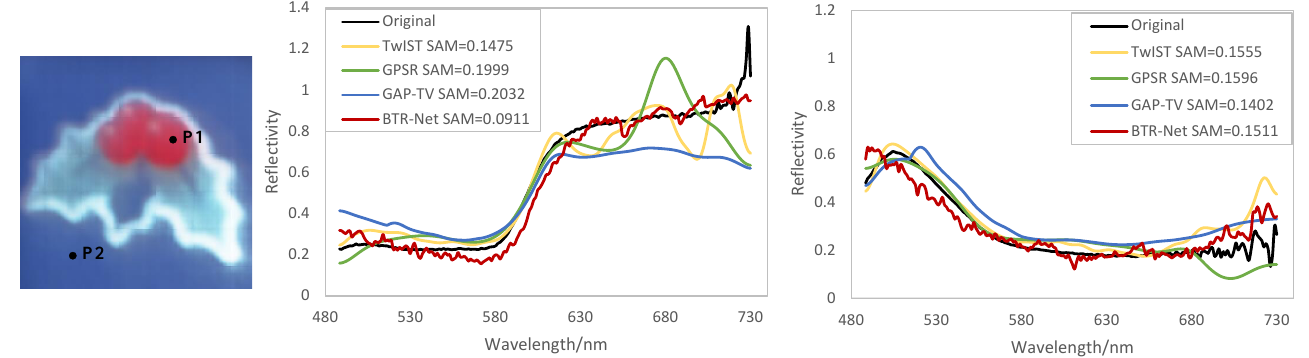
Figure 11. The reflection spectra of reconstructed results for two representative points whose positions are marked on the RGB image ( left ), P1 ( middle ) and P2 ( right